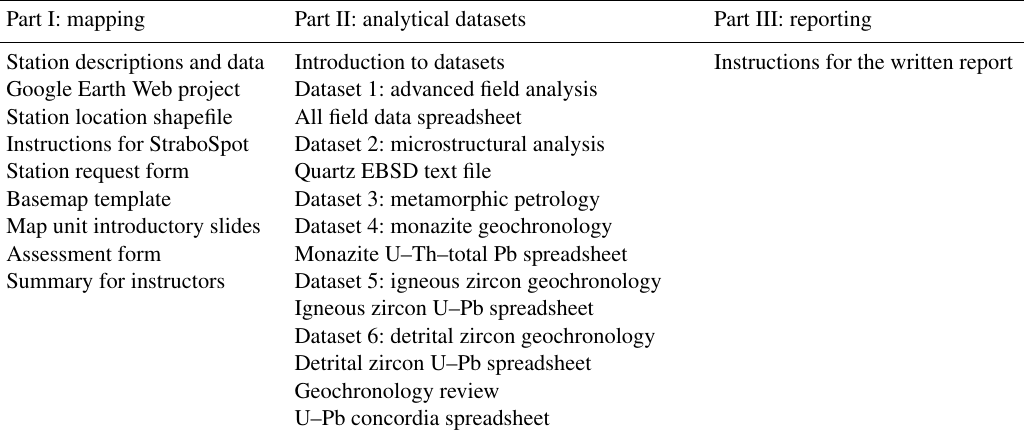
Table 2. Supporting